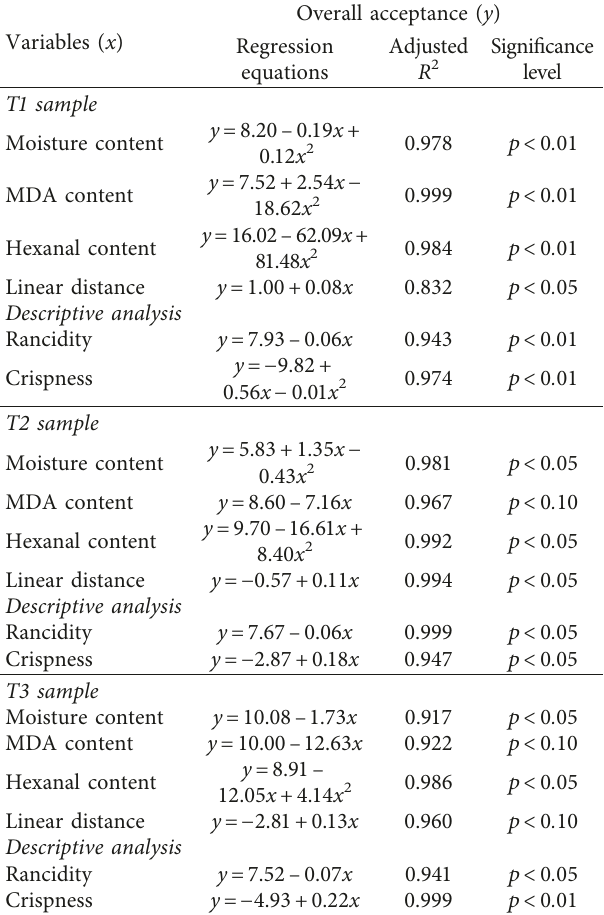
Table 5: Regression equations derived from independent variables acceptance y of Kaeb